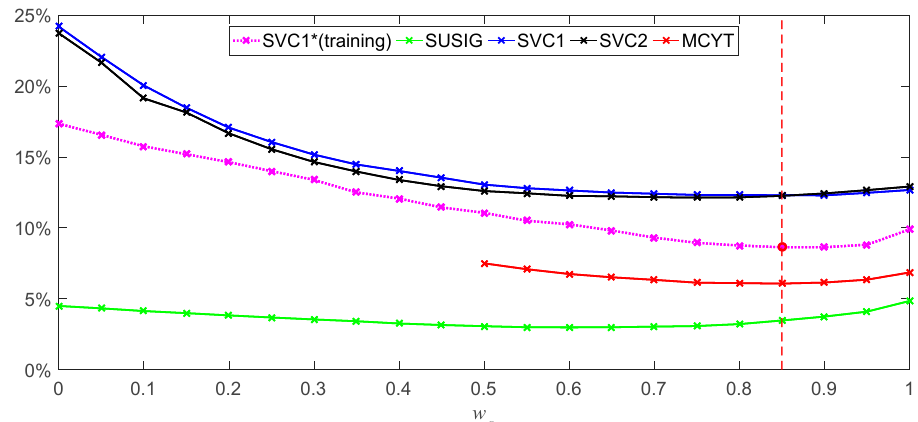
Figure 11. EERs and the mean on four signature datasets with different weight w a .